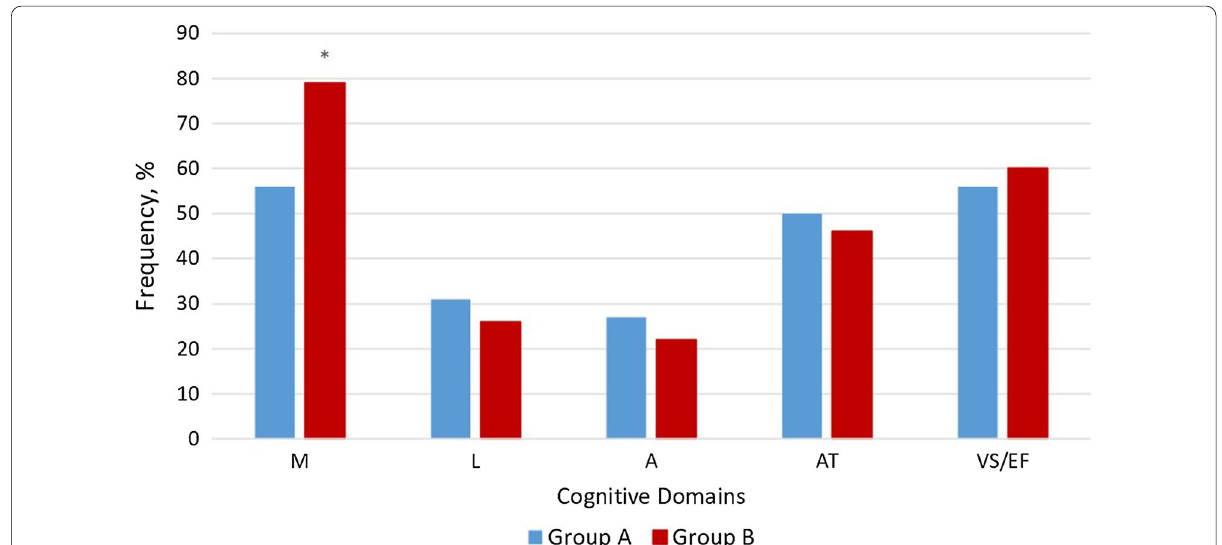
Fig. 1 Distribution of affected domains in participants of both groups depending on age (* p